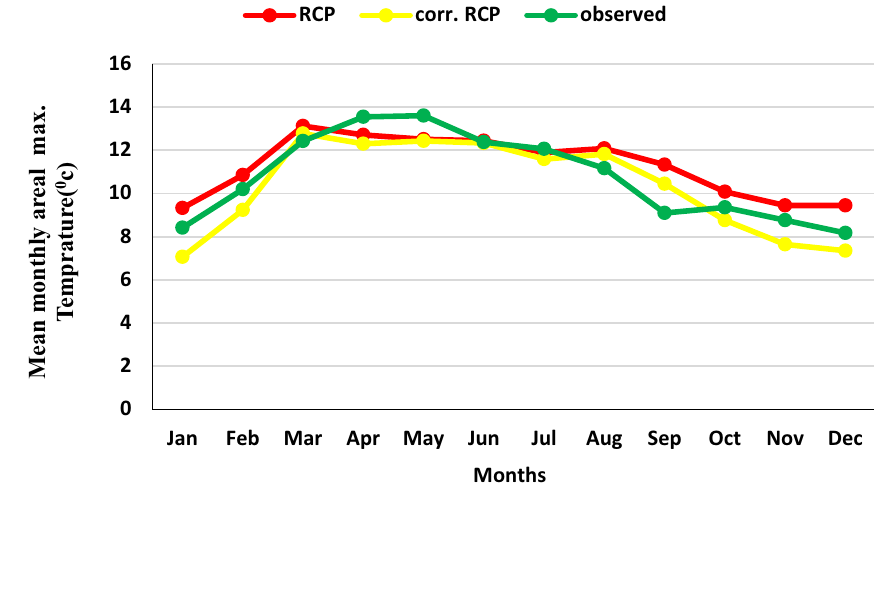
Fig. 4 Mean monthly areal minimum temperatures